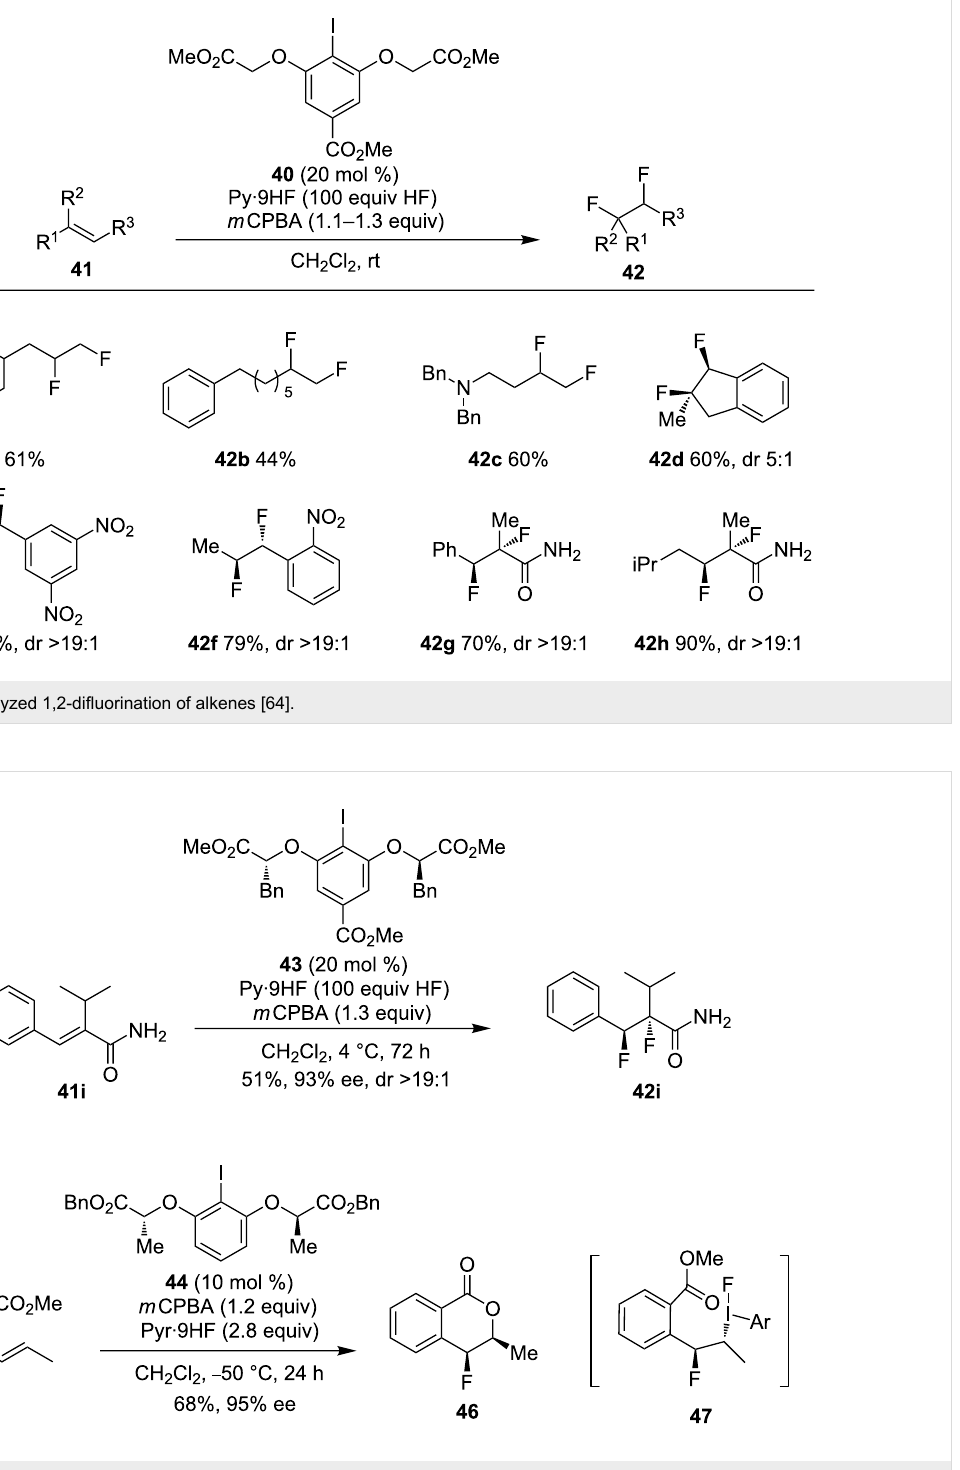
and diastereoselectivity. The same I(III) intermediate 47 was trapped by an o -carboxylic ester group leading to the syn- dia- stereoisomeric